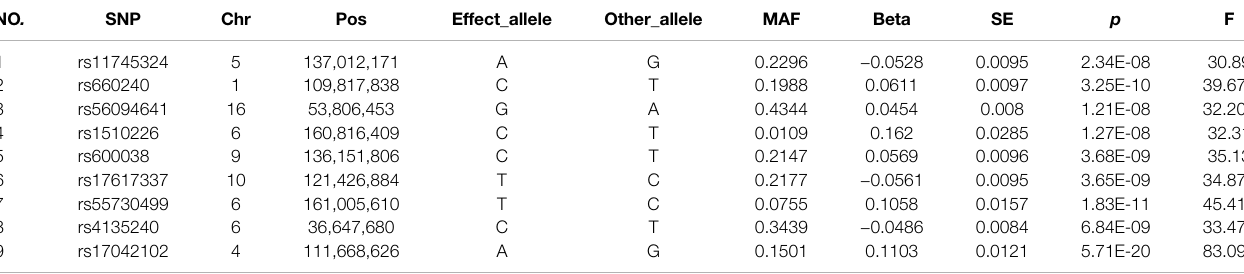
TABLE 4 | Detailed information of selected SNPs for MR analysis of the causal effect of HF on AD. NO . SNP Chr